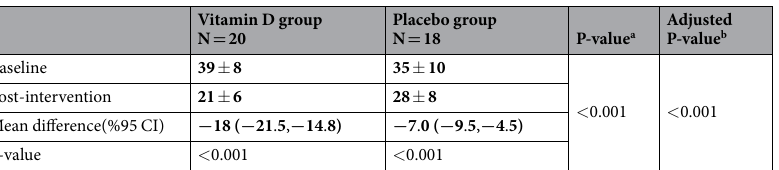
Table 4. Within- and between-group comparison of changes in mean score of the total PMS symptoms in the two study groups. a Resulted from independent samples t-test based on comparing mean difference between two groups. b Resulted from ANOCOVA based on comparing post-intervention values after adjustment for baseline values of outcomes, energy and vitamin E intake. Data are shown as mean ±